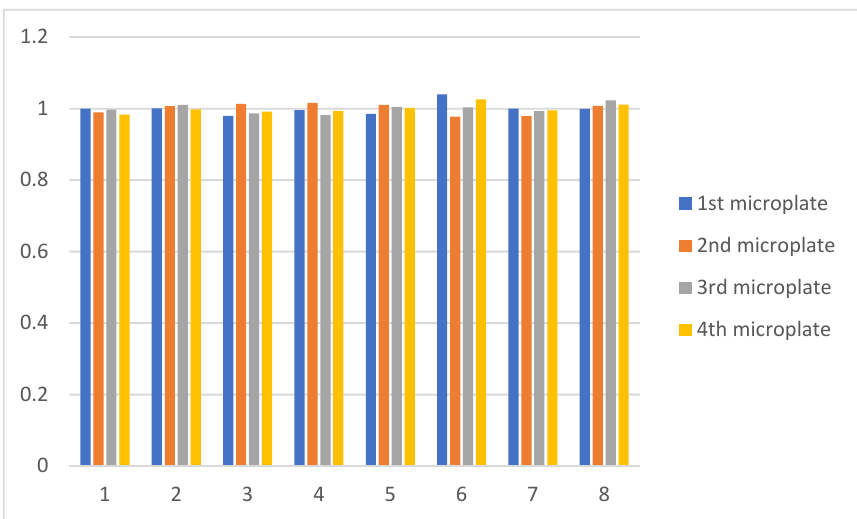
Figure 8. Normalized velocity distribution from the 1st to the 4th microplate of the numbering-up microreactor for radius of inlet and outlet tube 2 mm, at inlet gas flow rate Y g = 488.58 mL/min and Re = 101.76.